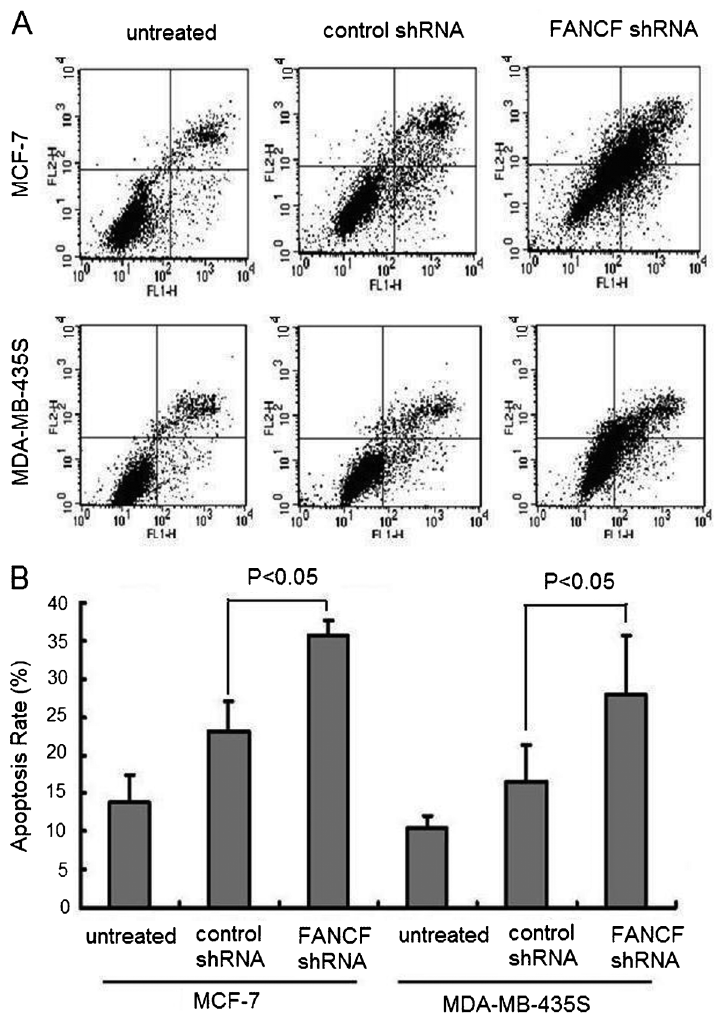
Figure 5. Apoptosis of MCF-7 and MDA-MB- 435S cells after transfection with FANCF-shRNA for 48 h. A , Apoptosis of cells was measured using FACScan after staining with FITC-Annexin V and propidium iodide. Cells in the lower right- hand quadrant are early apoptotic cells with exposed phosphatidylserine (FITC-Annexin V- positive) but intact membrane (propidium iodide-negative). B , Quantification of apoptosis in the indicated cell lines. Data are reported as means±SD of three independent experiments in triplicate. ANOVA followed by the post hoc test was used for statistical